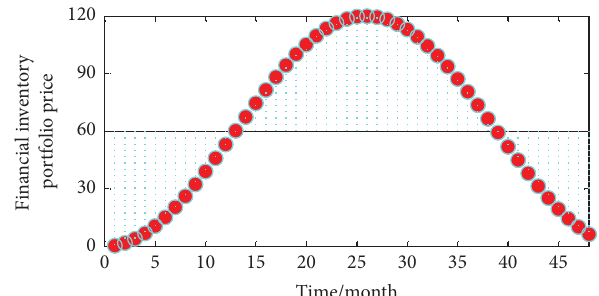
Figure 9: Normal distribution test of supply chain financial in- ventory portfolio price change rate series.